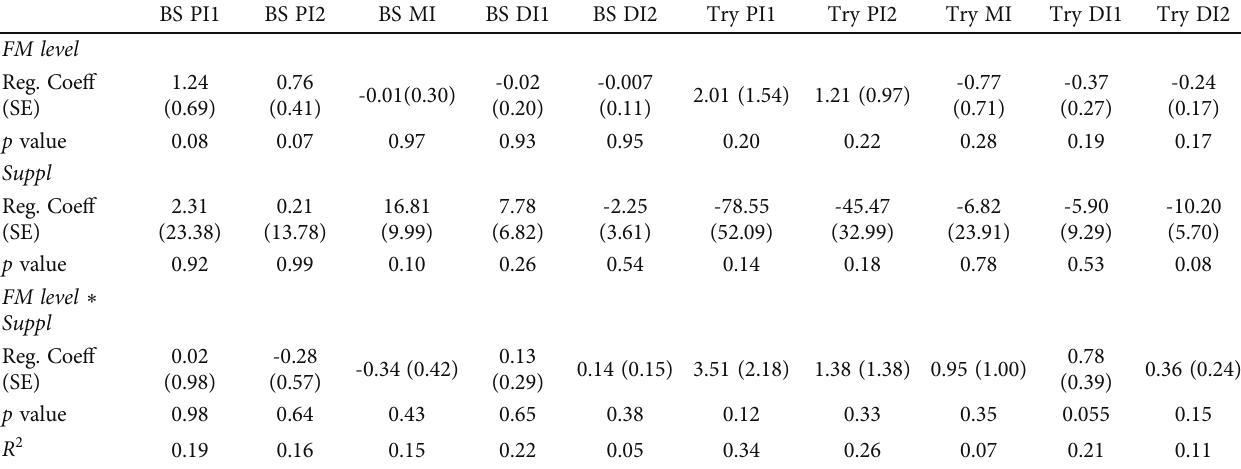
Table 5: Results of regression analyses for observations regarding bile salt (BS) concentration (mg/g) and trypsin (Try) activity (U/mg dry matter) in digesta collected from fi ve sections along the intestinal track † .